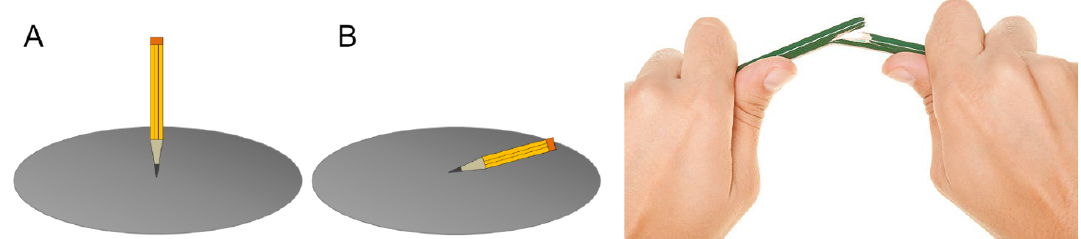
Figure 1 . A cartoon of the di(cid:11)erence between explicit and spontaneous breaking of a symmetry. Left: the symmetry is broken dynamically by the evolution of the system, which chooses a ground state not respecting such fundamental invariance. Right: the symmetry is broken explicitly by an external